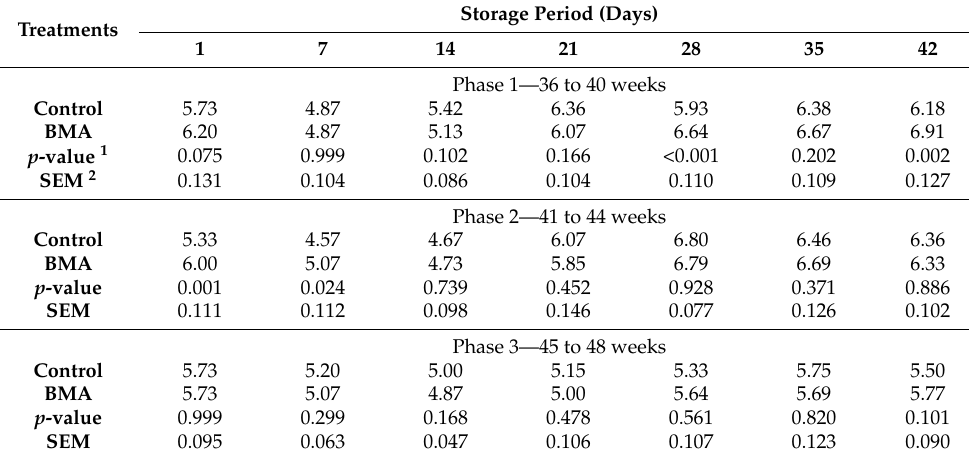
Table 4. Yolk color score (pallete) of eggs from laying hens fed with β -mannanase depending on storage time.